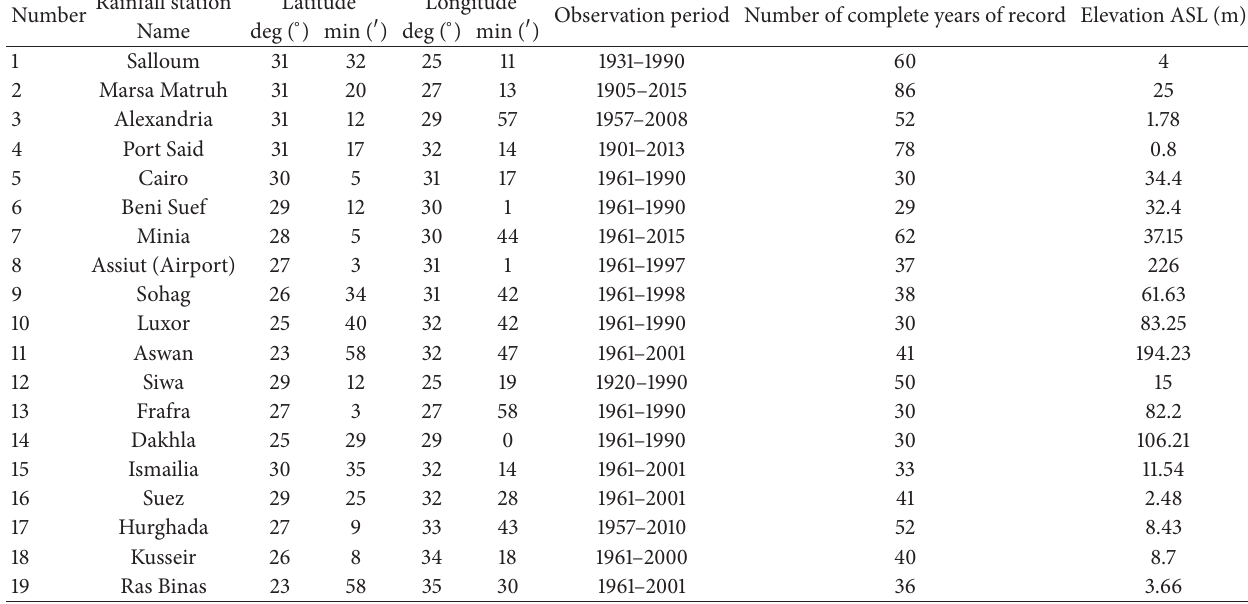
Table 1: Characteristics of available rainfall gauging